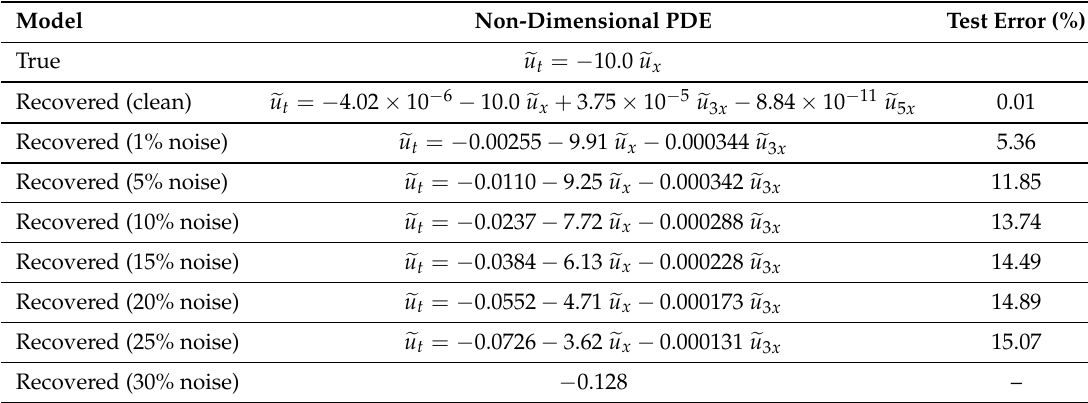
Table 4. Identifying wave equation using